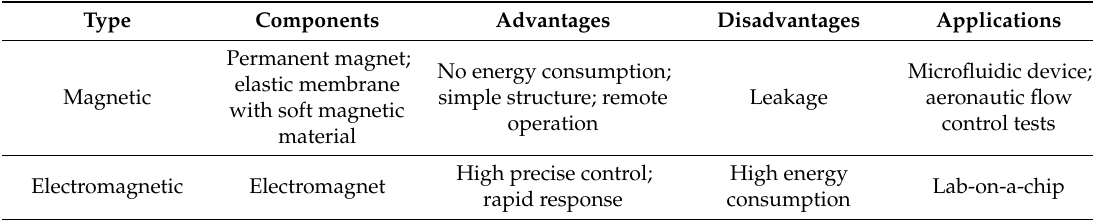
Table 3. Comparison of two types of magnetism driven microvalves.